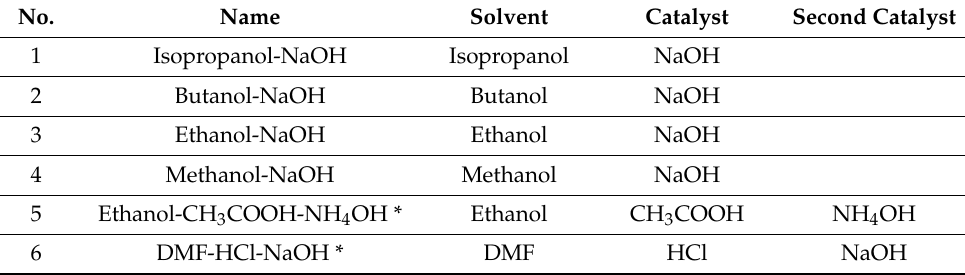
Table 1. Samples preparation regarding the